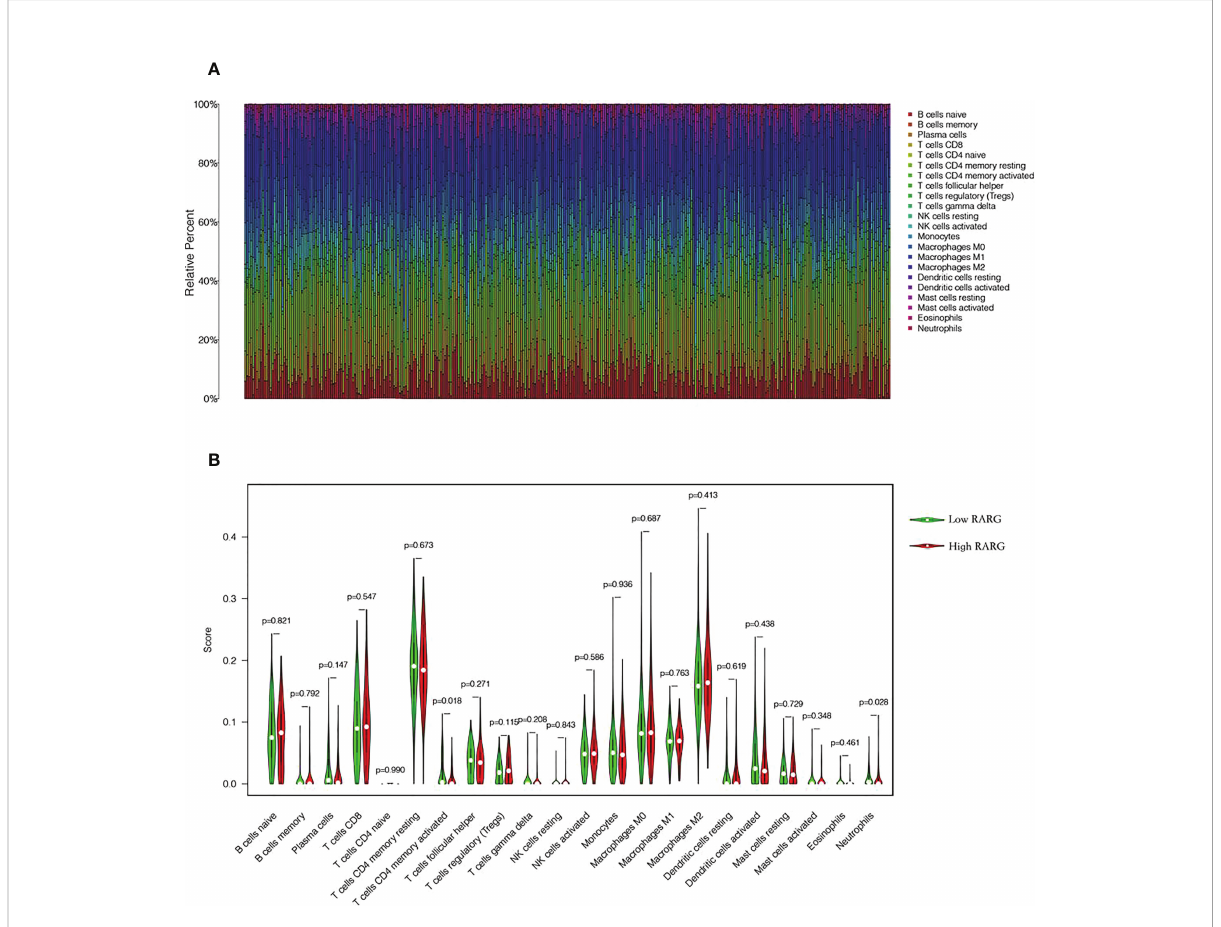
FIGURE 6 Analysis of immune cell in fi ltration in high and low RARG expression group. (A) In fi ltration abundance of 22 immune cells in each OC sample. (B) The differences in the in fi ltration degree of 22 immune cells between the RARG low expression and high expression groups. The green line represents RARG low expression group, and the red line is the RARG high expression